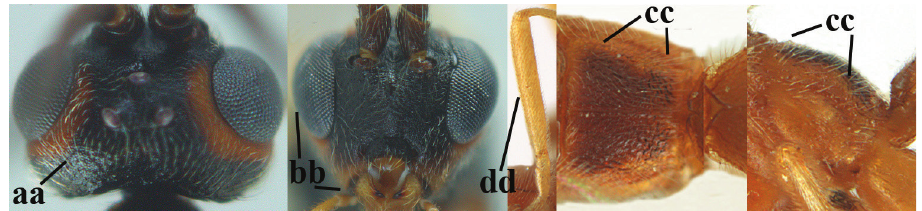
– Head transverse in dorsal view (aa) and lower in anterior view (bb); dorsal face of propodeum shorter and rounded posteriorly (cc), if more elongate then fore femur slenderer (dd) .................................................................. 19